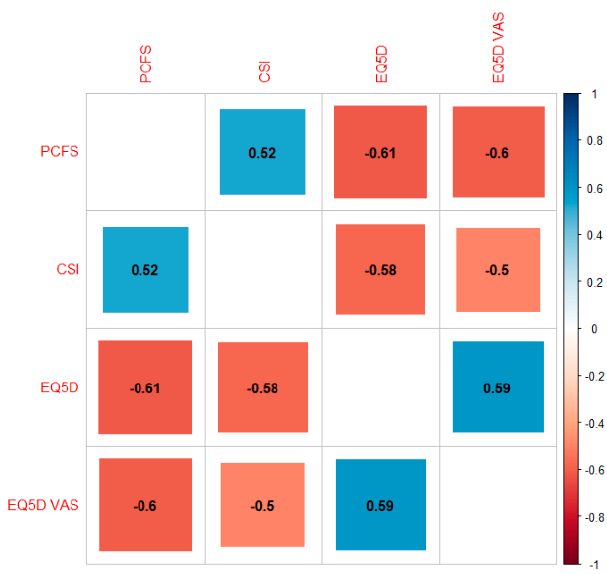
Figure 2. Correlation plot. Correlation coefficients range from − 1 (red) to +1 (blue) and presented with the actual value on the plot. Abbreviations. CSI: Central Sensitization Inventory, PCFS: Post- COVID-19 Functional Status Scale, VAS: Visual Analogue Scale.